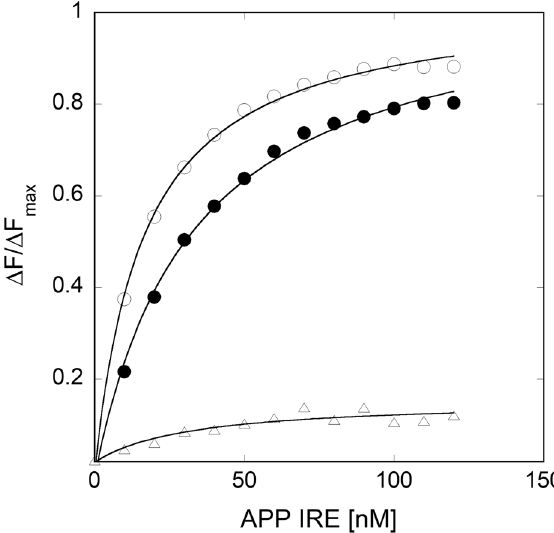
Figure 4. Fluorescence intensity measurements for the binding of APP IRE mRNA to IRP1 protein in the presence of iron (anaerobic). APP mRNA (57-nucleotides) was melted and annealed prior to each titration and incubated with IRP1 protein. 100 nM IRP1 protein was incubated with varying amounts of APP IRE mRNA in the absence (— ○ —) and presence (— ● —) of 50 µM iron. The excitation wavelength was 280 nm and emission wavelength were 332 nm. The solid lines are the fitted curves.